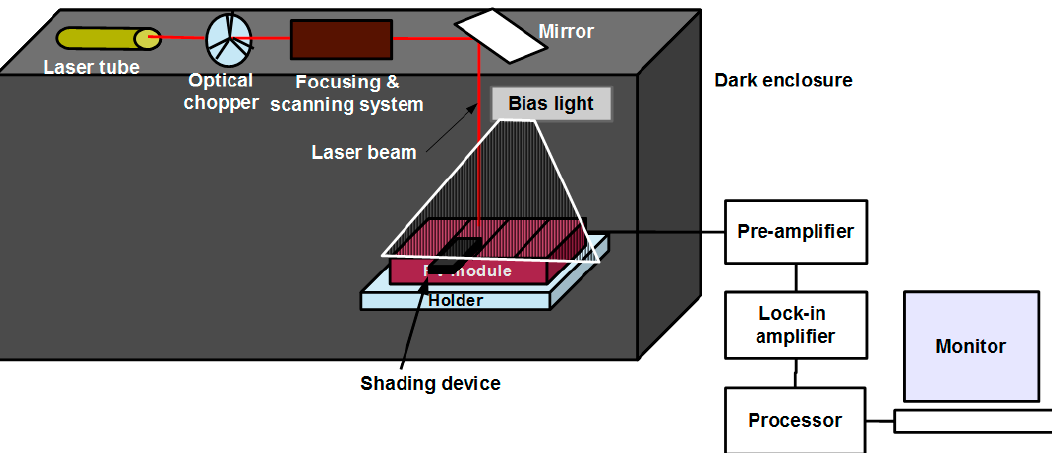
Figure 5. Schematic of li -LBIC measurement system.